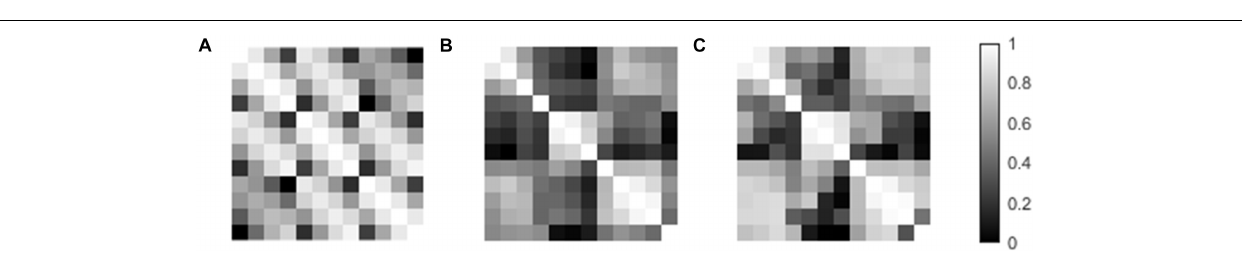
FIGURE 5 | The template paired correlation coefficient matrixes. (A) Paired matrix of the template direction vector. (B) Paired matrix of the template volume. (C) Paired matrix of template volume after